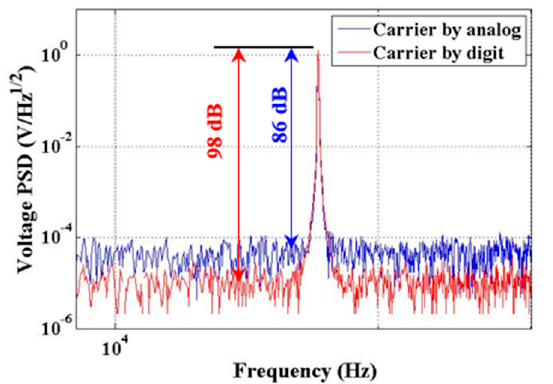
Figure 3. The contrast between the analog and digital methods of producing a carrier wave. The red line is the digital method, which has a better performance in the center carrier frequency.